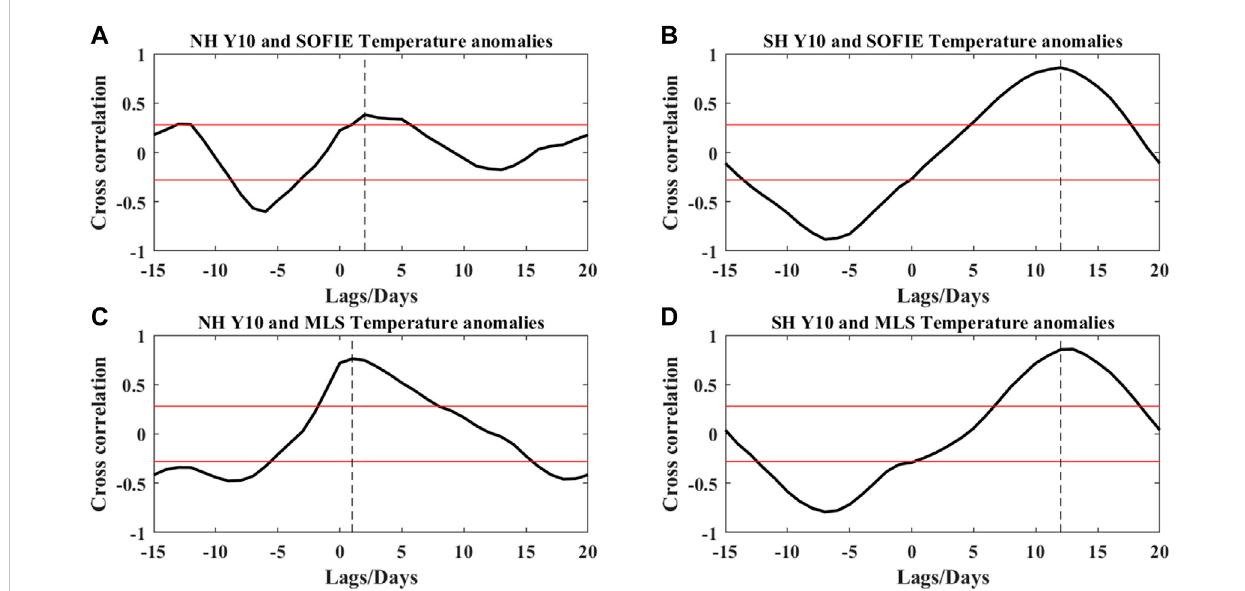
FIGURE 2 (A) Correlation curve of temperature anomaly from SOFIE and Y10 anomaly in the NH calculated through SEA. (B) Correlation curve of SOFIE temperature anomaly and Y10 anomaly in the SH. (C) Correlation curve of temperature anomaly from MLS and Y10 anomaly in the NH. (D) Correlation curve of MLS temperature anomaly and Y10 anomaly in the SH. Red lines correspond to the correlation coef fi cients with statistical signi fi cance equal to